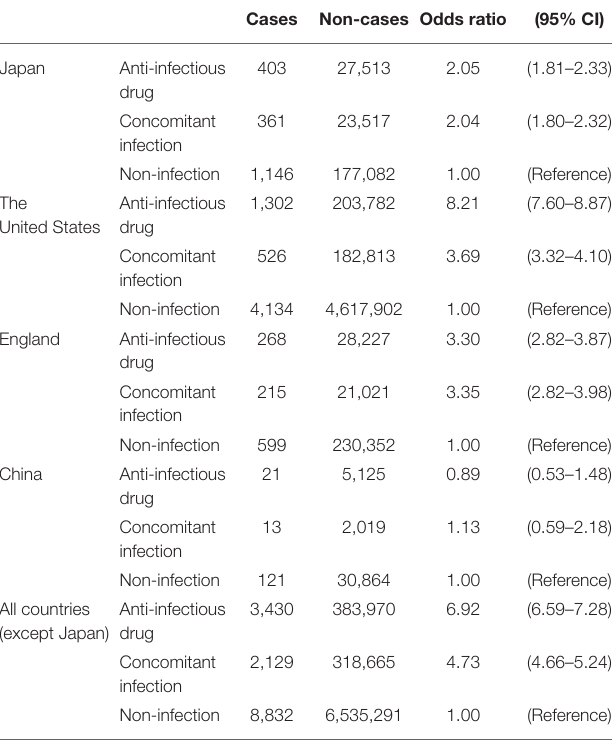
TABLE 2 | Odds ratios for the association between infection and SJS/TEN in the FAERS database. Cases Non-cases Odds